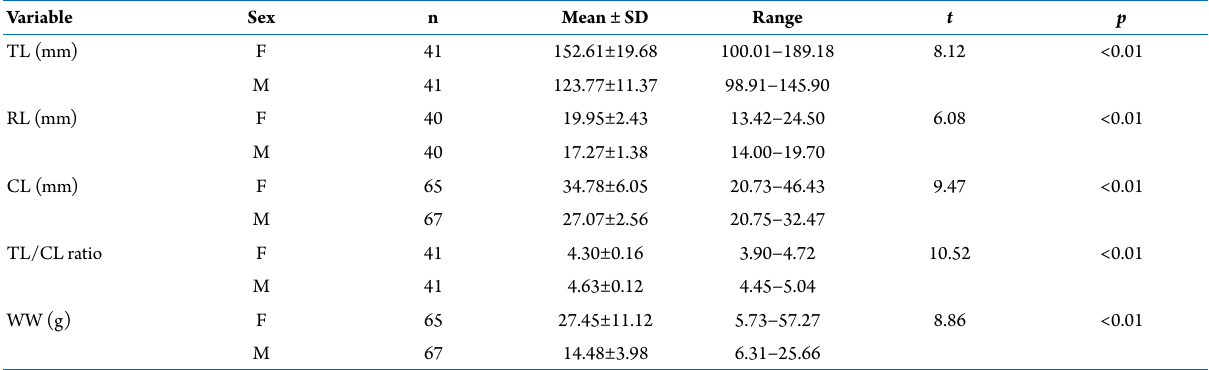
Figure 2. Number of Farfantepenaeus brasiliensis (Latreille, 1817) per carapace length class (CL) caught on the coast of Sergipe, northeastern Brazil, from May 2015 to May 2016. Table 1. Length and weight data for females (F) and males (M) of Farfantepenaeus brasiliensis (Latreille, 1817) caught on the coast of Sergipe, northeastern Brazil. TL = total length, RL = rostrum length, CL = carapace length, WW = wet weight, n = sample size, SD = standard deviation, t = Student t-value comparing mean values between females and males, p = probability associated with